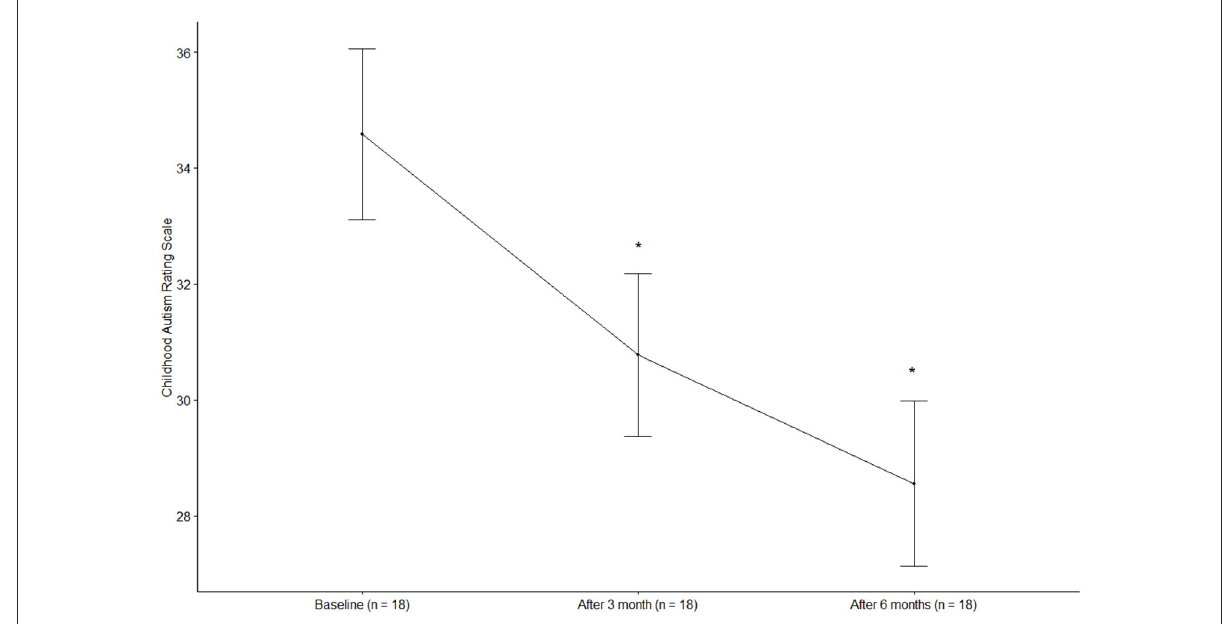
FIGURE1 Changes in the childhood autism rating scale. * p < 0.0001, compared with baseline (Dunnett post-hoc